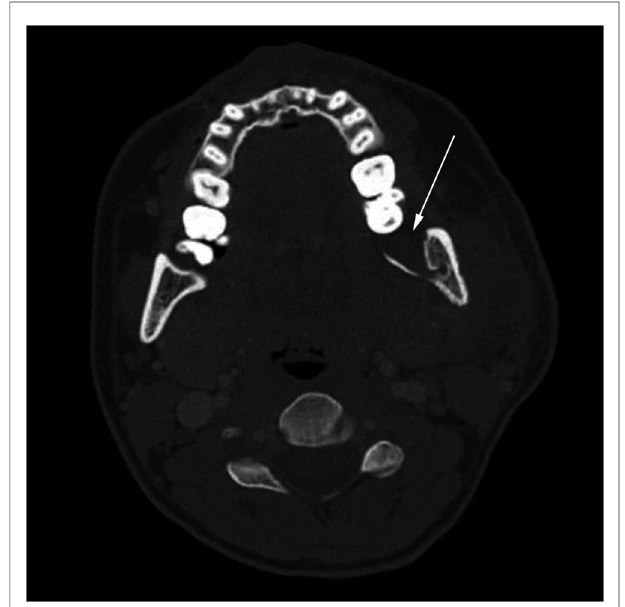
FIGURE 1 | Preoperative axial CT scan of the neck at the C2 level showing osteomyelitis in region 38 of the mandibular ramus. The affected side shows loss of cortical margin (arrow) and soft tissue